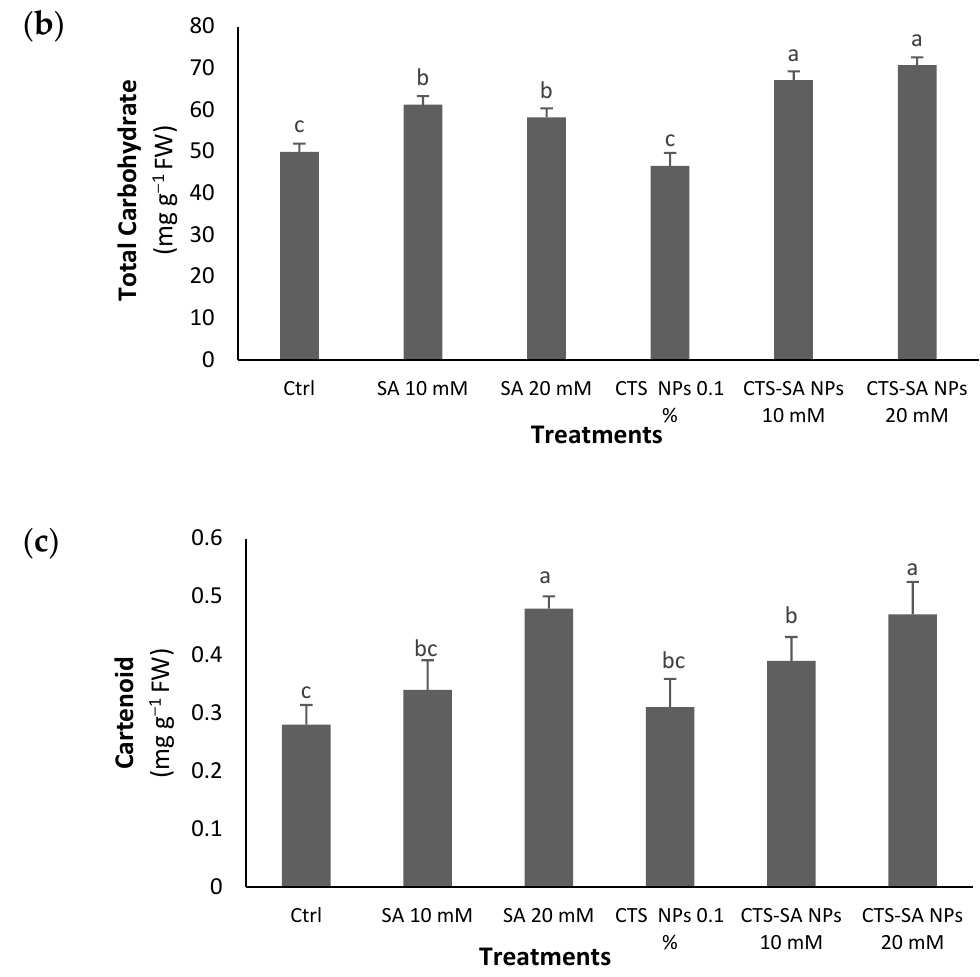
Figure 2. The effect of salicylic acid (SA) (10 and 20 mM), chitosan (CTS) (0.1%), and their combination in nano-form (CTS-SA NPs) treatments on vitamin C (vit C) ( a ), total carbohydrates ( b ), and carotenoids ( c ) of grape ( Vitis vinifera L.) cv. Red Sultana. Different letters indicate significantly different values at p ≤ 0.05.